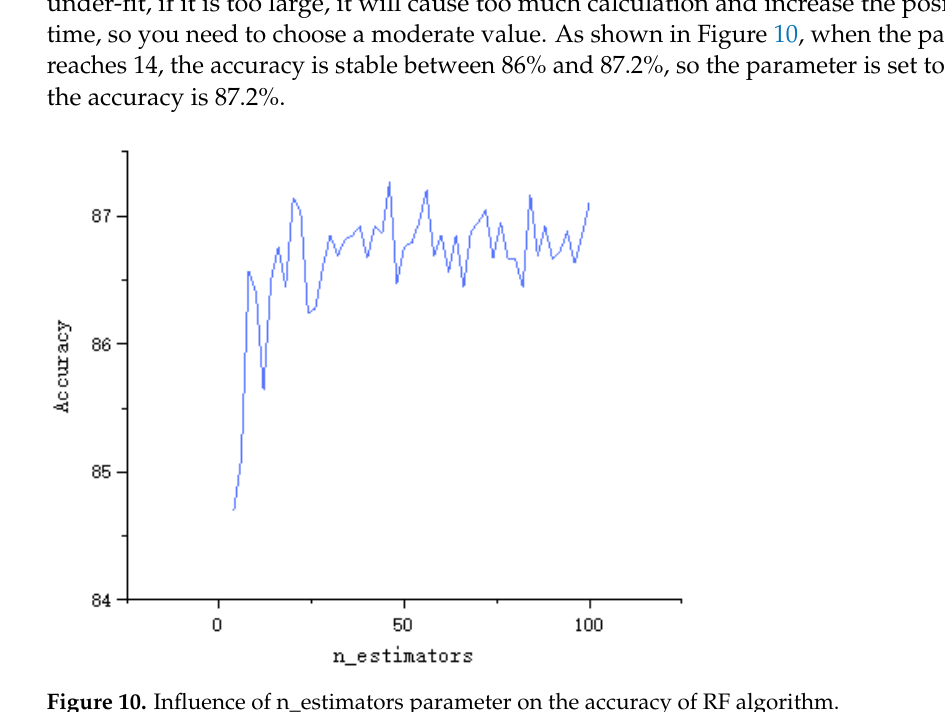
Figure 9. Algorithm positioning time comparison at edge points.